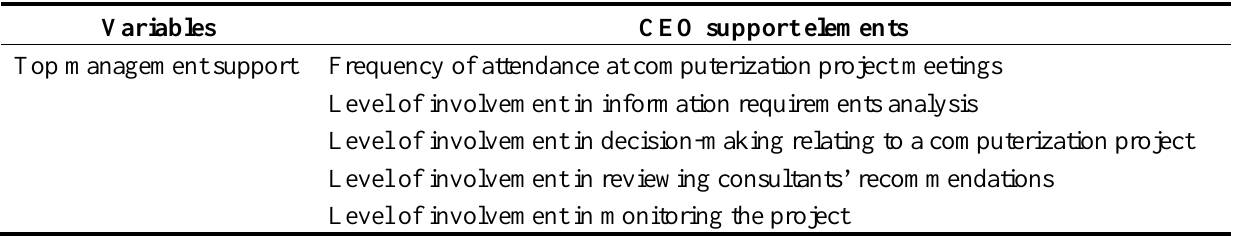
Table 2. Thong et al. [12] definition of top management